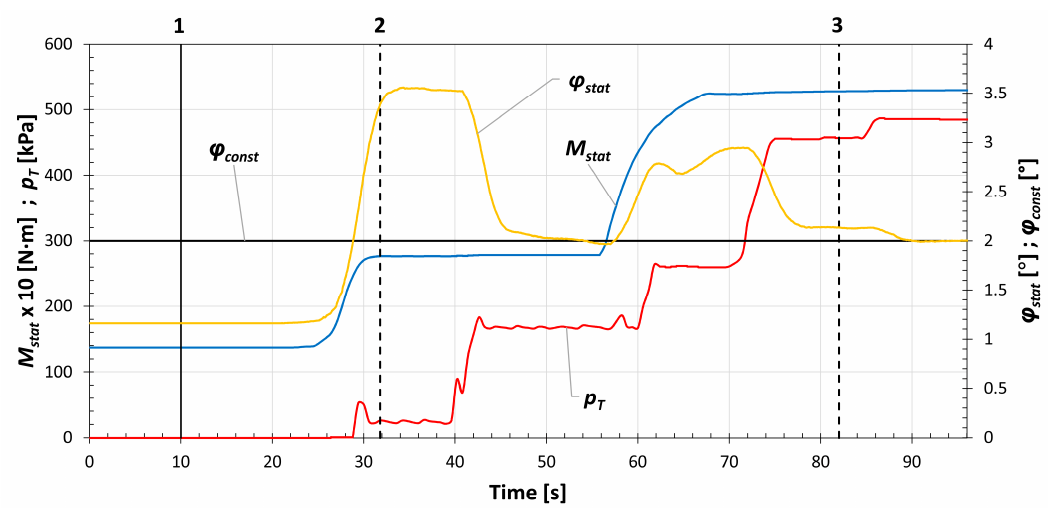
Figure 9. Control process by loading the mechanical system.